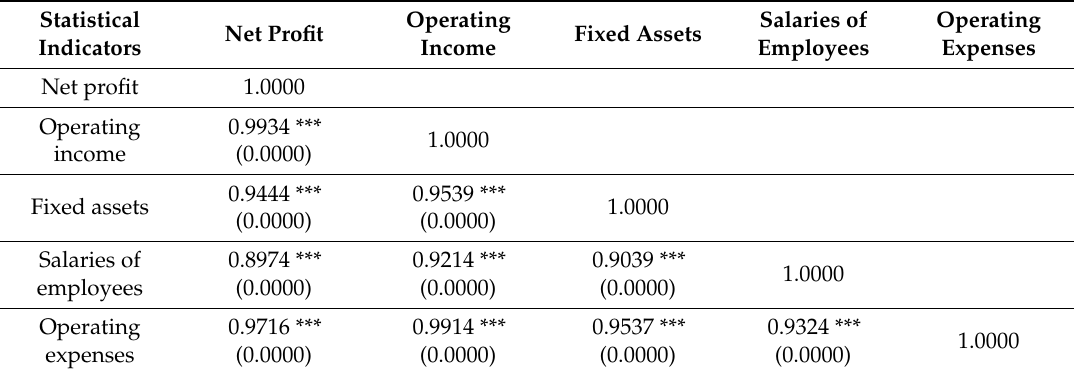
Table 11. Test of